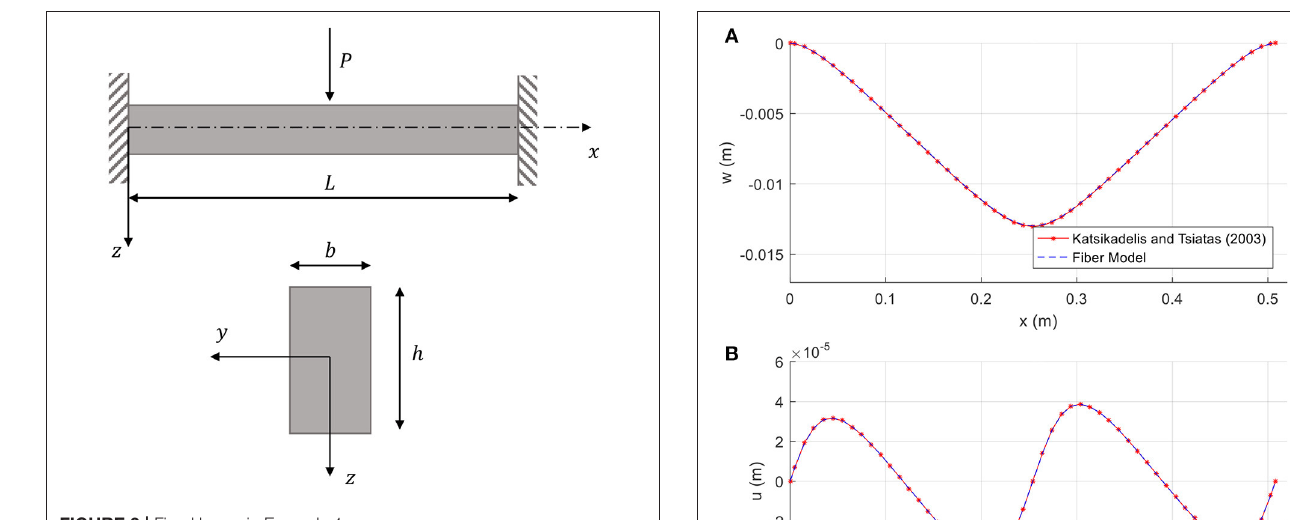
FIGURE 3 | Fixed beam in Example 1.